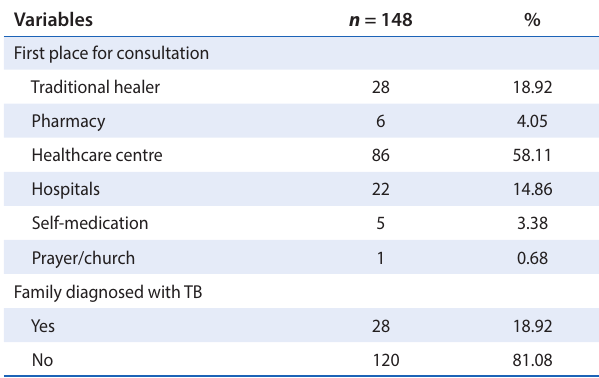
Table 2: First place consulted before being diagnosed with TB and history of TB in the